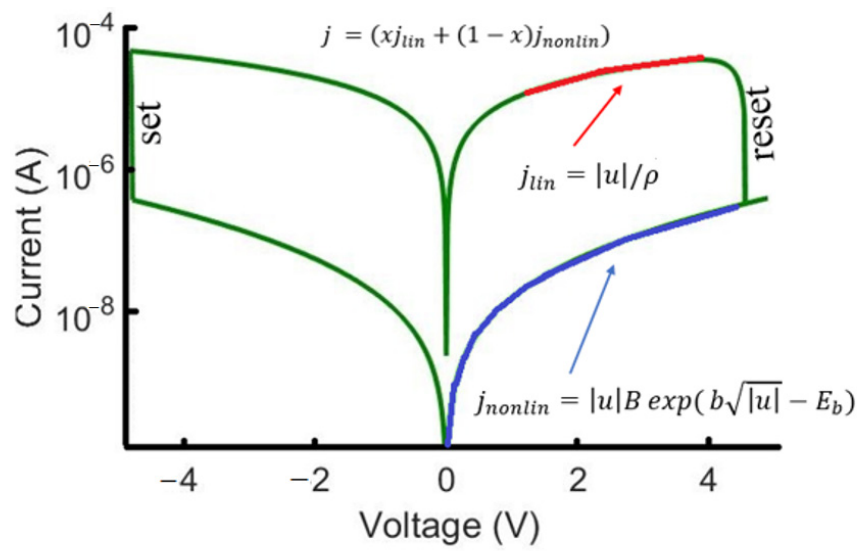
Figure 4. I–V characteristics of the memristive device obtained as a result of numerical Figure 4. I − V characteristics of the memristive device obtained as a result of numerical simulation.